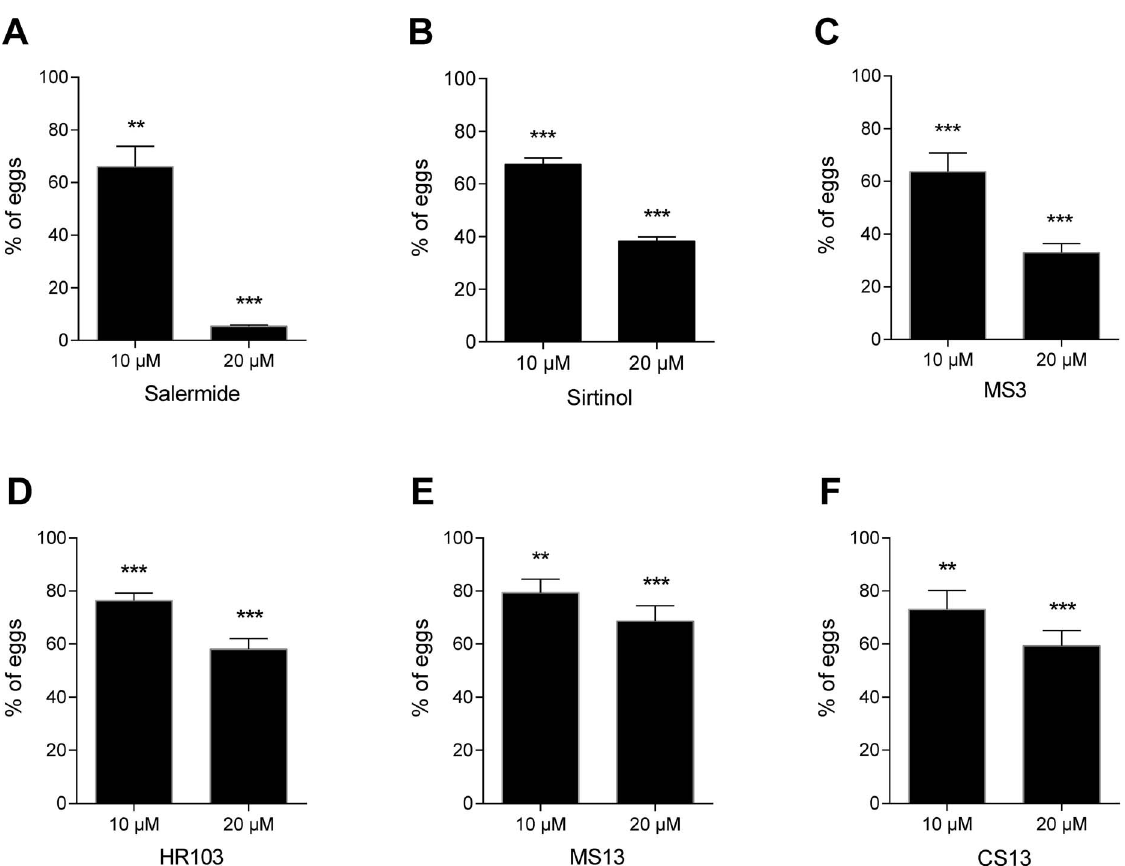
Figure 7. Total number of eggs laid during 5 days treatment with sirtuin inhibitors at 10 m M and 20 m M. Results obtained with (A) Salermide, (B) Sirtinol, (C) MS3, (D) HR103, (E) MS13 and (F) CS13 were expressed as mean % of eggs laid by treated worms compared to controls ( 6 SD, three independent experiments). Statistical analyses were performed using student’s t-test, and significance is displayed as follows: ** p , 0.01, ***p , 0.001.